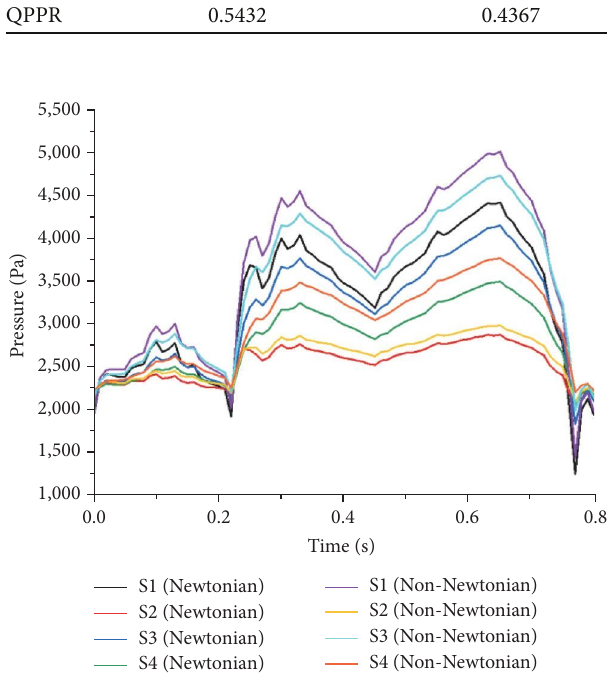
F IGURE 6: Maximum pressures on normal branches.